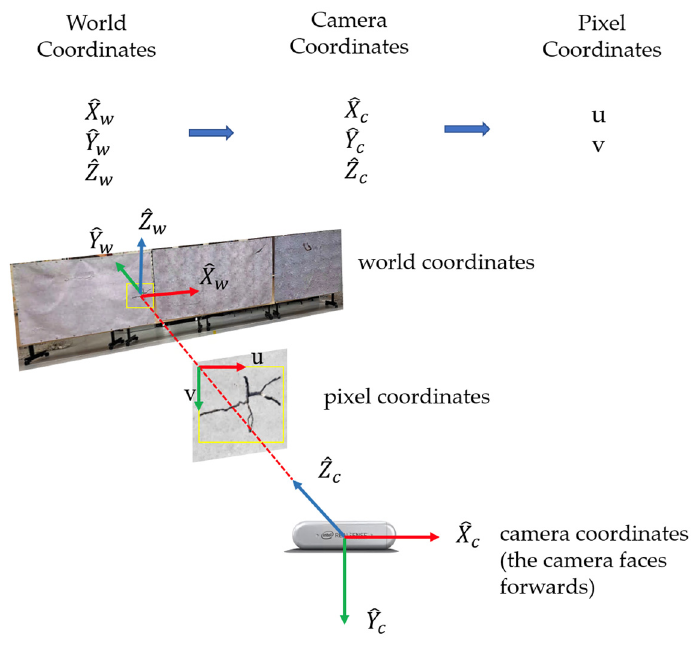
Figure 11. 3D-to-2D forward projection.